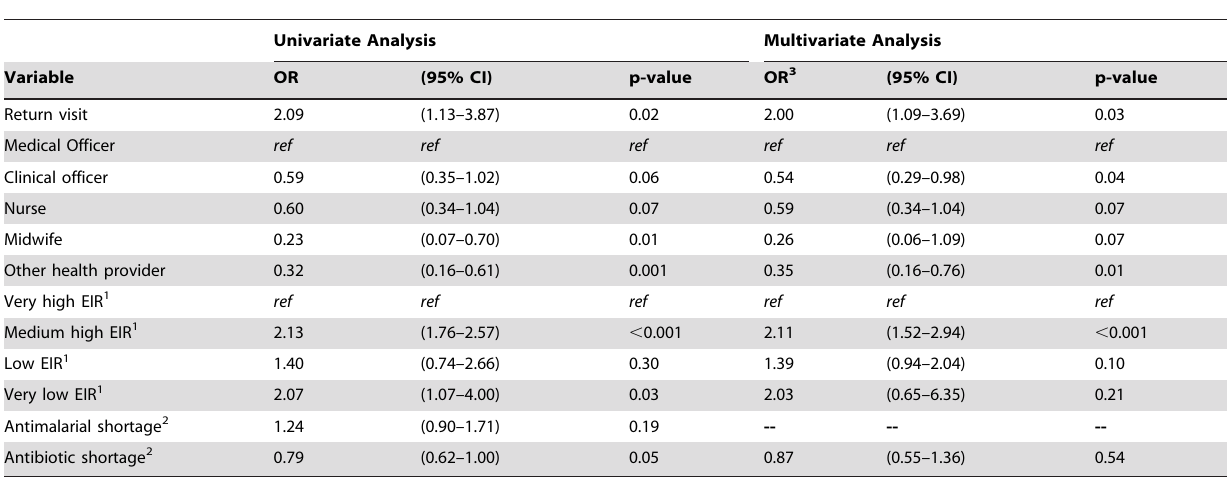
Table 5. Association between operational exposure variables and inappropriately withholding antibiotic treatment to patients with a clinical indication for antibiotics.